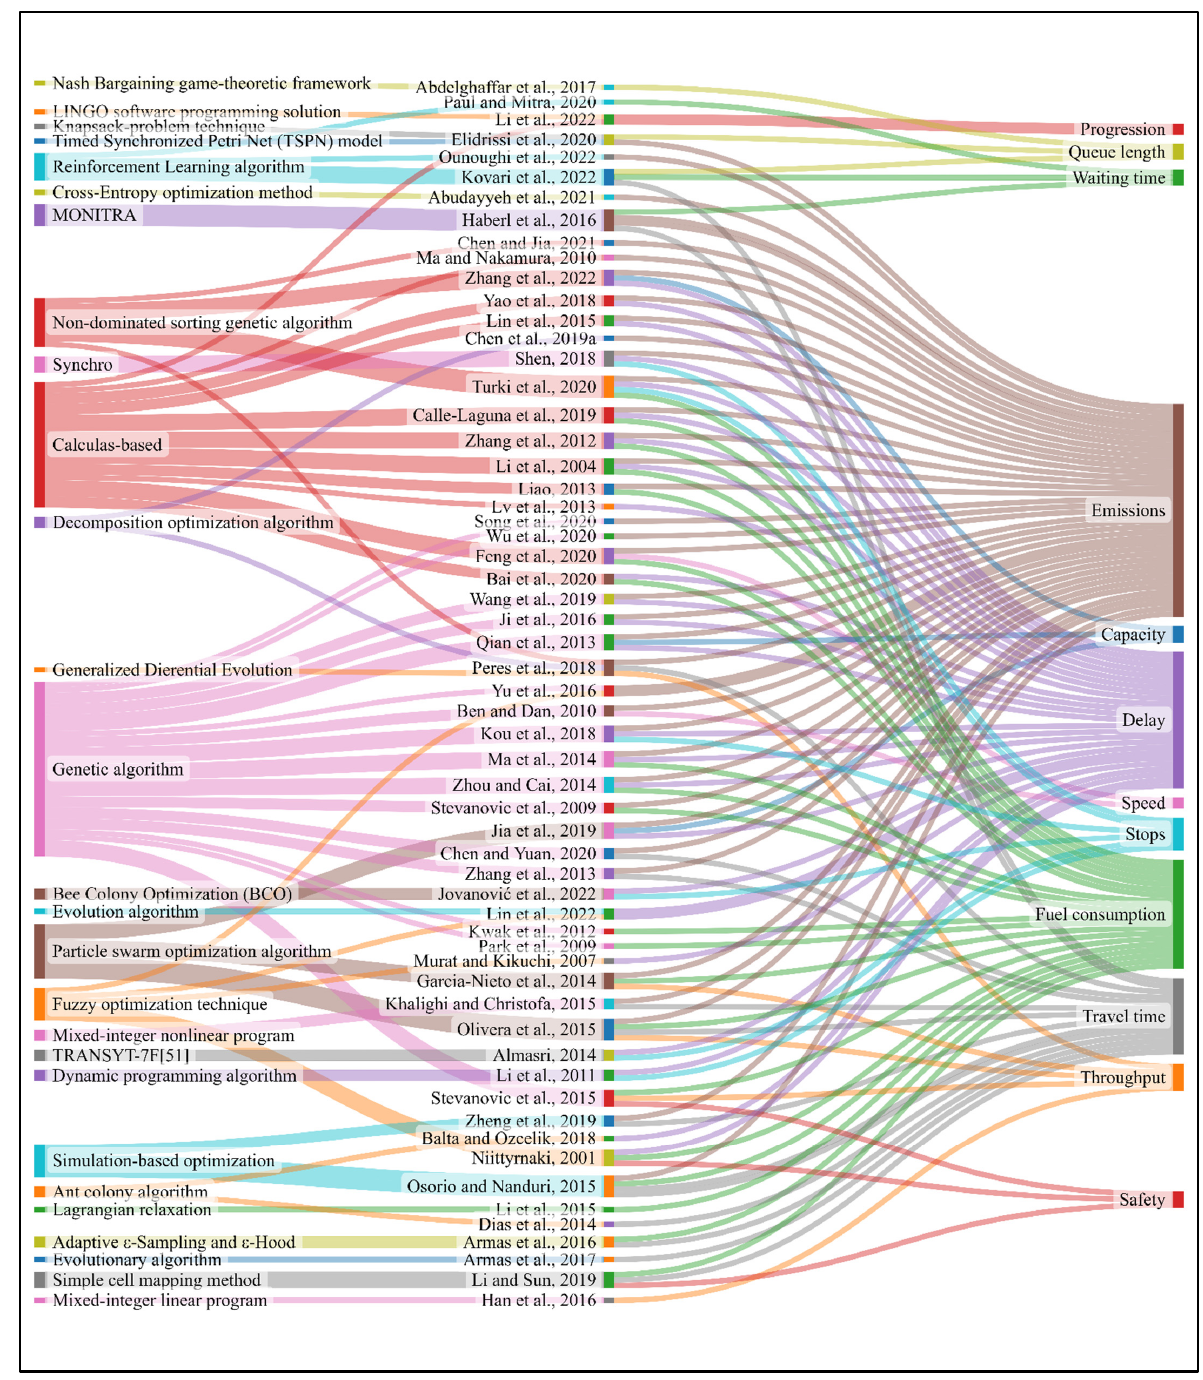
Figure 5. Connections between studies, optimization techniques, and objective functions. Kovari et al., 2022 [66], Li et al., 2022 [67], Zhang et al., 2022 [68], Jovanovi ć et al., 2022 [69], Ounoughi et al., 2022 [70], Abudayyeh et al., 2021 [71], Chen and Jia, 2021 [72], Lin et al., 2022 [73], Feng et al., 2020 [74], Bai et al., 2020 [75], Chen and Yuan, 2020 [76], Elidrissi et al., 2020 [77], Paul and Mitra, 2020 [78], Song et al., 2020 [79], Al-Turki et al., 2020 [80], Wu et al., 2020 [81], Calle-Laguna et al., 2019 [82], Chen et al., 2019a [83], Jia et al., 2019 [84], Li and Sun, 2019 [85], Wang et al., 2019 [86], Zheng et al., 2019 [87], Balta and Ozcelik, 2018 [88], Yao et al., 2018 [89], Kou et al., 2018 [90], Peres et al., 2018 [91], Shen, 2018 [92], Abdelghaffar et al., 2017 [93], Armas et al., 2017 [94], Ji et al., 2016 [95], Yu et al., 2016 [96], Haberl et al., 2016 [97], Han et al., 2016 [98], Tanaka, 2016 [99], Khalighi and Christofa, 2015 [100], Lin et al., 2015 [101], Olivera et al., 2015 [102], Osorio and Nanduri, 2015a